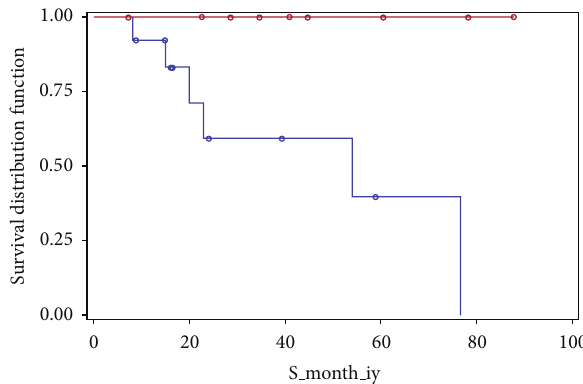
Figure 1: Survival curves of PE + R / C (red) versus PE (blue) alone